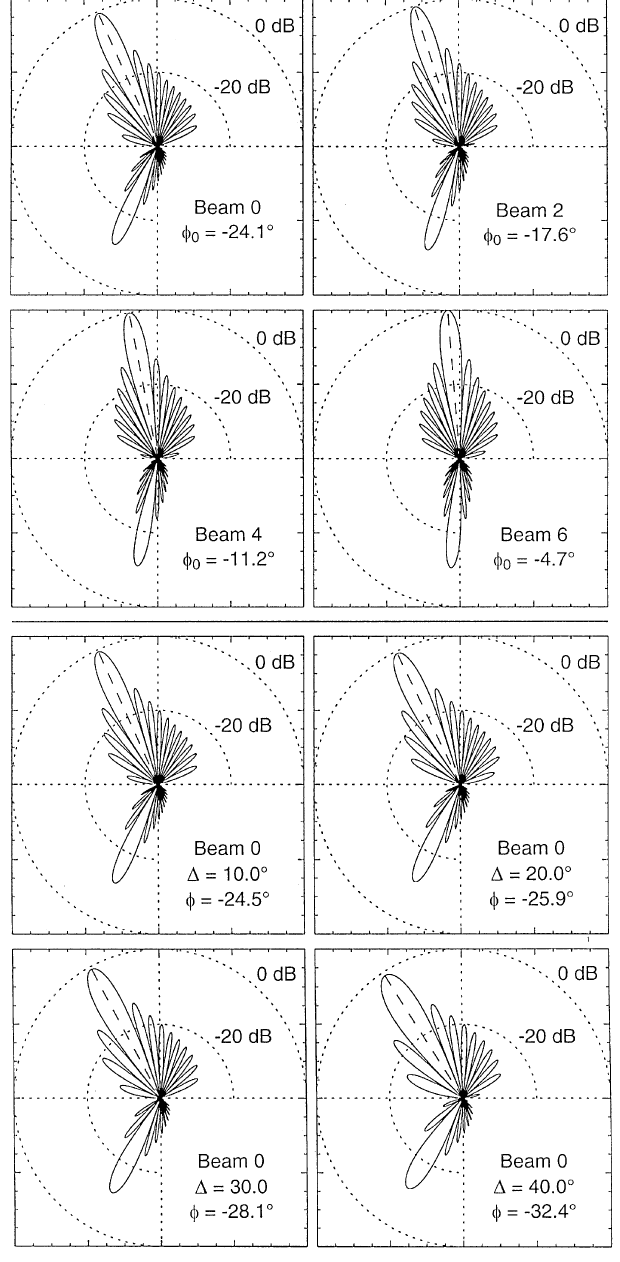
Fig. 1. One-way beam patterns of the phased antenna array at 10 MHz. ( „ op four panels ) beams 0, 2, 4 and 6 at elevation angle (cid:68) " 0 ° . ( Bottom four panels ) beam 0 at (cid:68) " 10 ° , 20 ° , 30 ° and 40 °